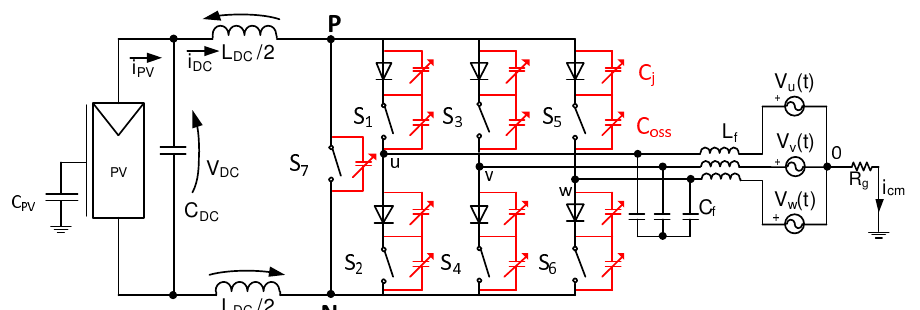
Figure 1. Schematic of CSI7 topology.